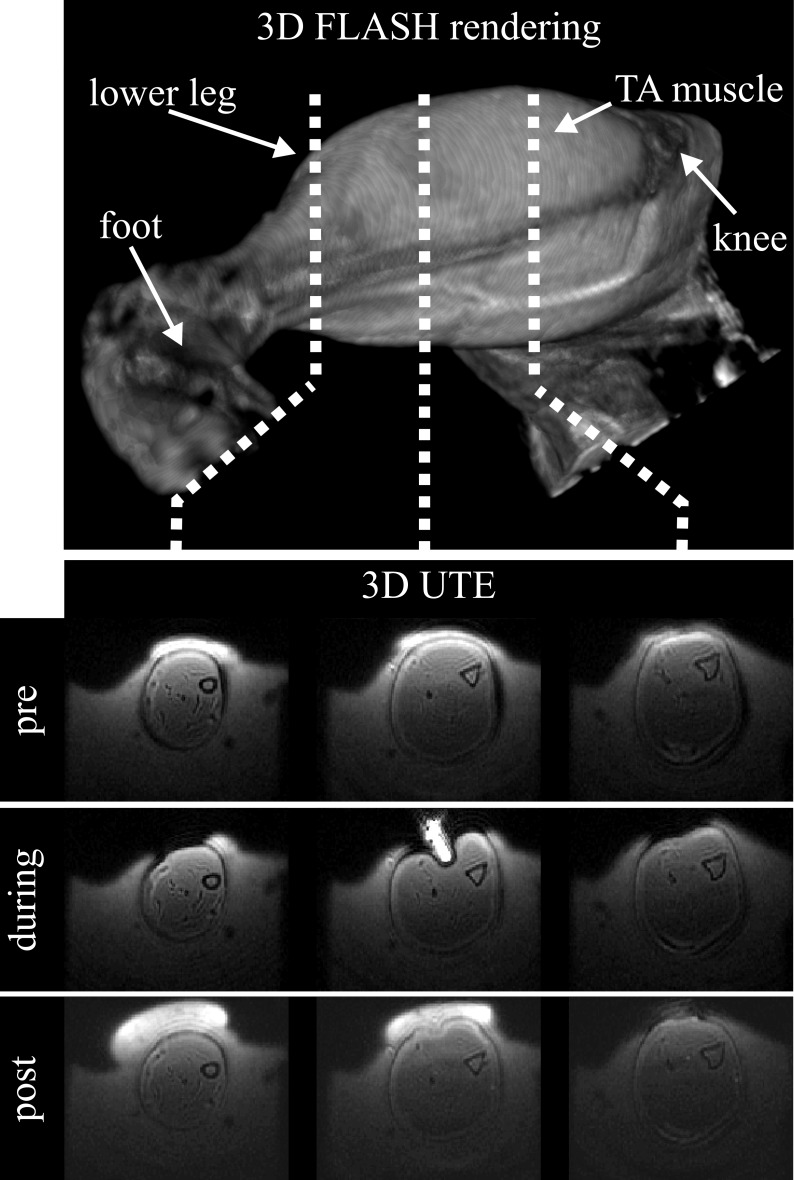
Alginate cast visualization.Axial 3D ultra-short echo time images of the alginate cast surrounding the rat leg, pre, during and post indentation. FLASH 3D rendering shows anatomical landmarks and location of selected 3D ultra-short echo time images.